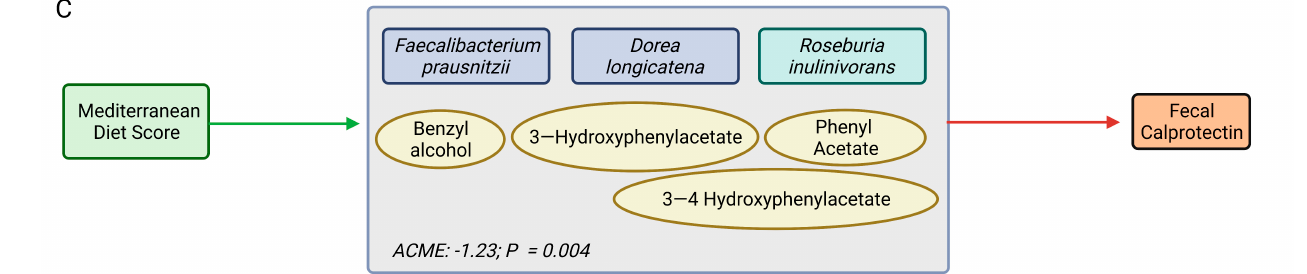
Figure 8. Weighted gene co-expression network analysis (WGCNA). ( A ) A specific health-associated microbiome guild of four taxa significantly influences the association between Mediterranean diet score and fecal calprotectin in a 3-step manner. ( B ) The metabolite cluster mediates the negative association between the Mediterranean diet score and fecal calprotectin. ( C ) A combination of features (three taxa and four metabolites) demonstrates an even stronger mediating effect between the Mediterranean diet score and fecal calprotectin. Green arrows represent a positive association and red arrows represent a negative association. Abbreviations: MDS, Mediterranean diet score; FCP, fecal calprotectin; ACME, average causal mediation effect; prop. mediated; proportion mediated. Created with BioRender.com (accessed on 5 January